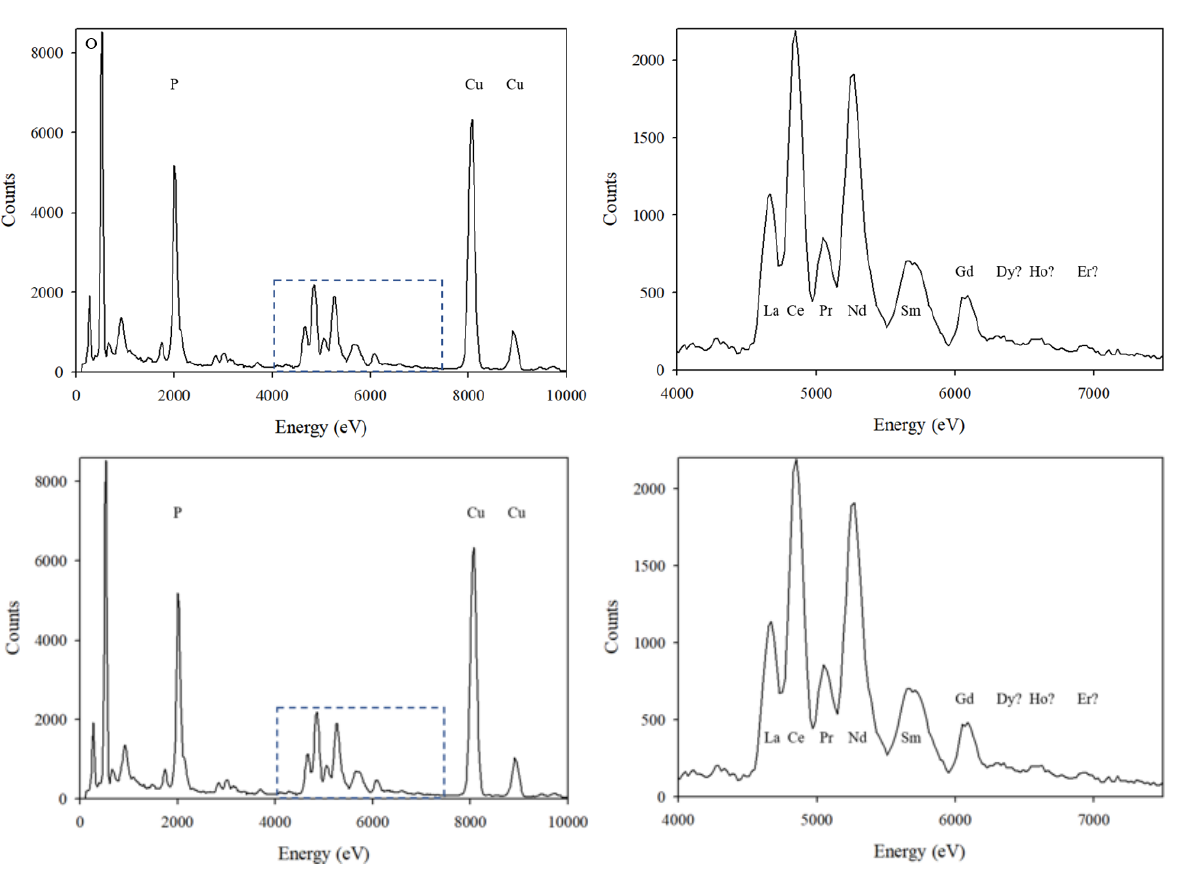
Figure 11. EDS for area 1 within area 1213. The full counts for the 0 to 10,000 eV range are shown on the ( left ) and a restricted count range for the 4000–7500 eV range is shown on ( right ) (dashed box on full-range figure indicates the area of the right figure). The Dy, Ho, and Er “peaks” do not represent significant concentrations of those elements. The Cu peak belongs to the grid holder, not the sample.